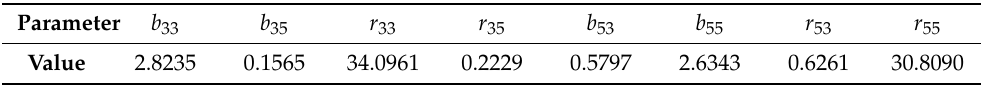
Table 3. The parameters in Equation